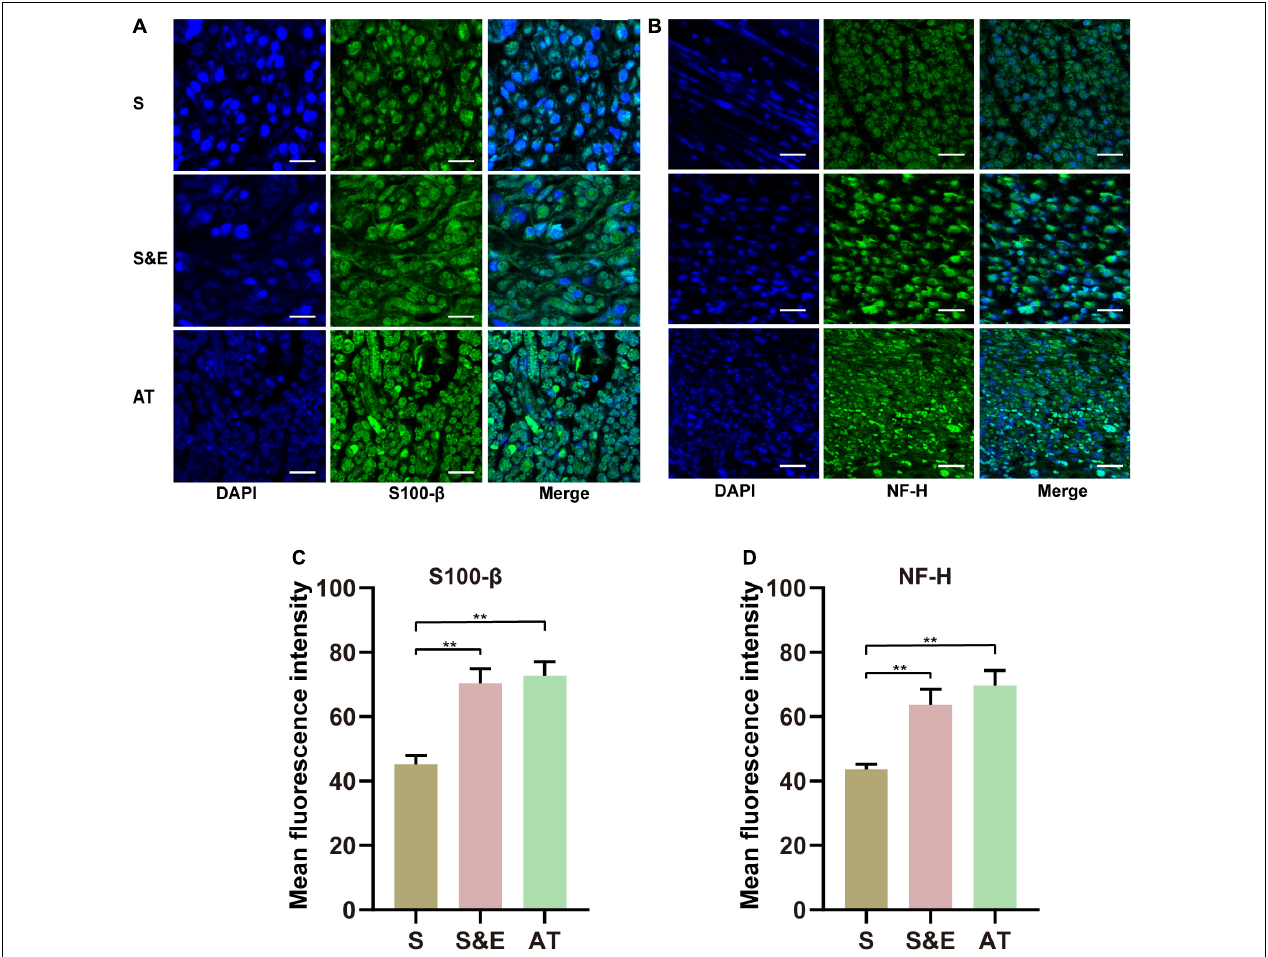
FIGURE 10 | (A,B) S100- β and NF-H immunofluorescence images of regenerated nerves at 12th week after implantation. (C,D) Mean fluorescence intensity of S100- β and NF-H. Scales = 30 µ m. n = 5, ** p <